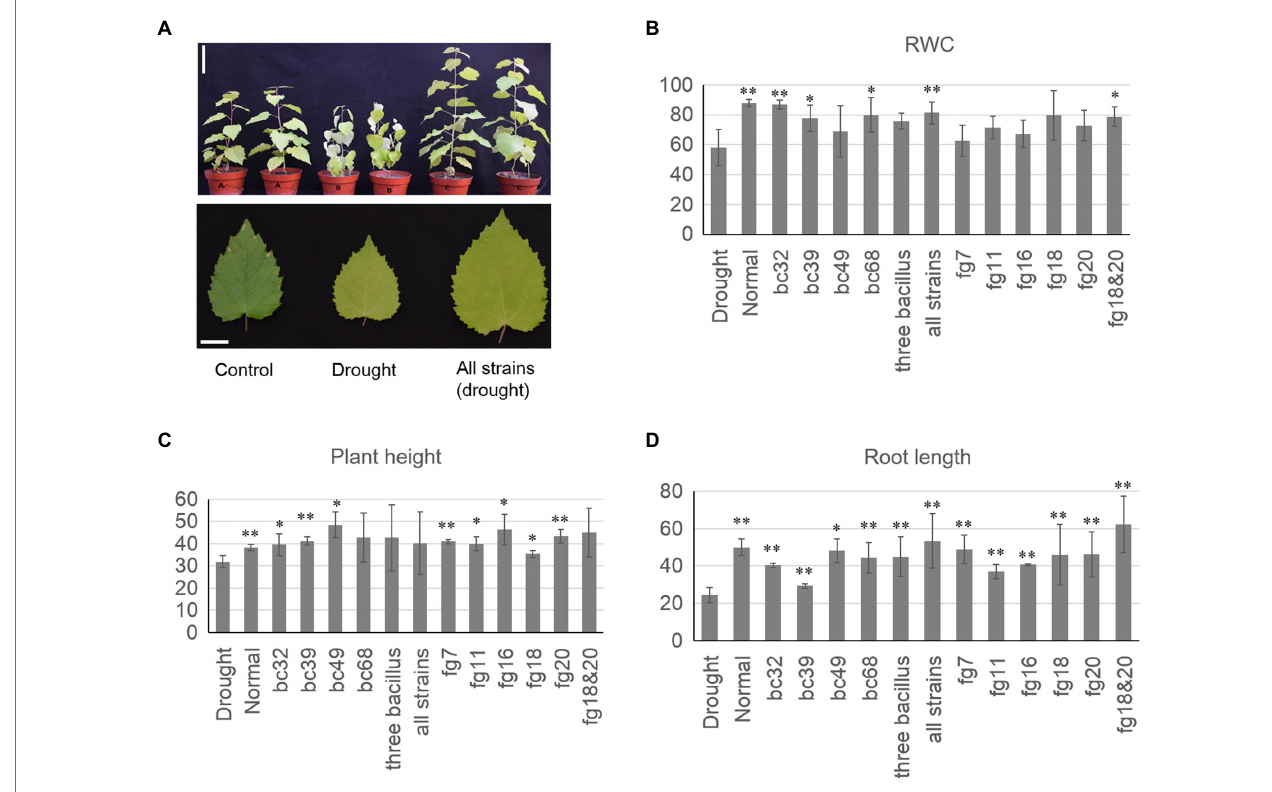
FIGURE 4 | Isolated strains enhance the drought tolerance of poplar. (A) Inoculation of all mixed bacteria strains enhanced the drought tolerance of poplar. Bars (up) = 10 cm. Bars (down) = 2 cm. (B) The relative water content (RWC) of different inoculation groups. (C) The plant height of different inoculation groups. (D) The root length of different inoculation groups. RWC = [(fresh weight of leaves − dry weight of leaves)/(Turgid weight of leaves − dry weight of leaves)] × 100. All strains ( Bacillus megaterium bc32, Bacillus endophyticus bc39, Bacillus arbutinivorans bc49, and Streptomyces rochei bc68); three Bacillus ( Bacillus megaterium bc32, Bacillus endophyticus bc39, and Bacillus arbutinivorans bc49; * p < 0.05; ** p <